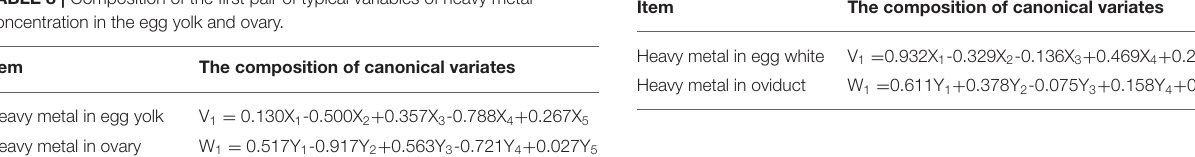
TABLE 10 | Composition of the first pair of typical variables of heavy metal concentration in the egg white and the oviduct. Item The composition of canonical